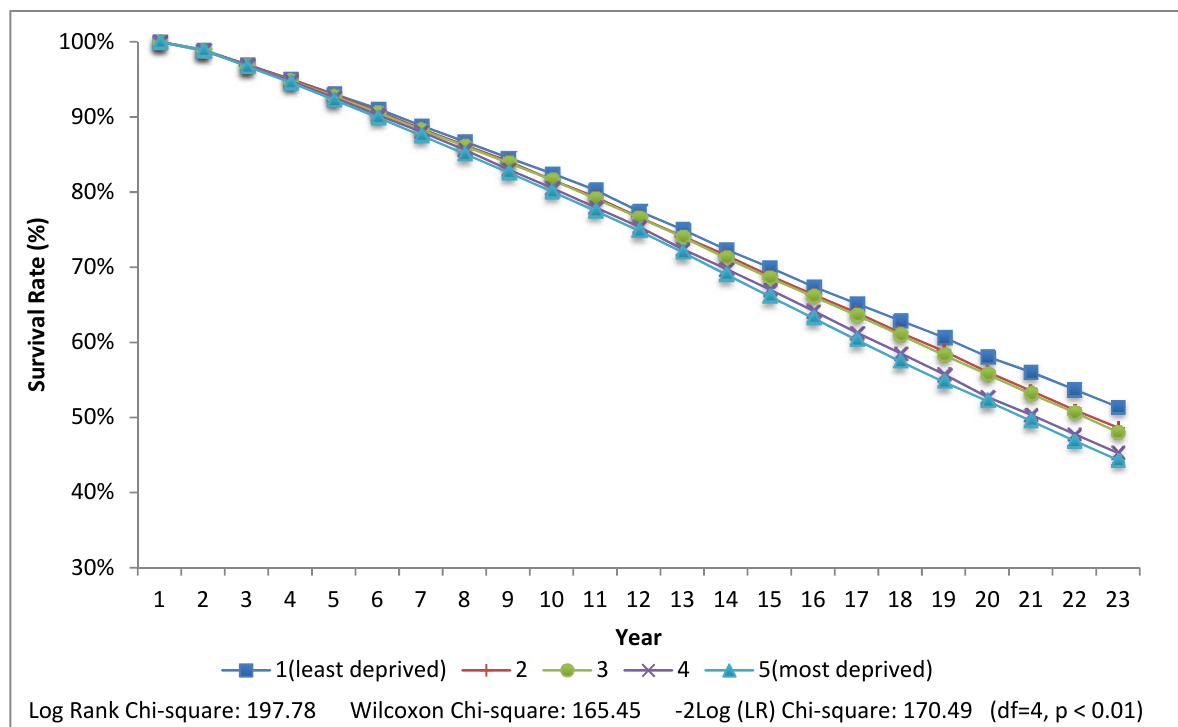
Figure 2. Rate of survival by quintiles of neighborhood material deprivation for low income